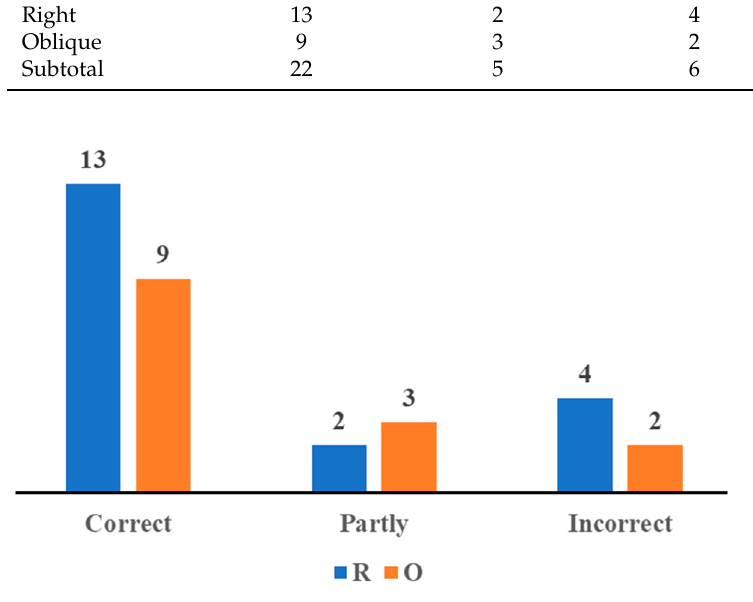
Figure 9. Frequency distribution of student’s results by using different strategies. Table 13. Frequencies of student’s results by using different strategies. Table 14. Results of chi-test on student’s results by using different